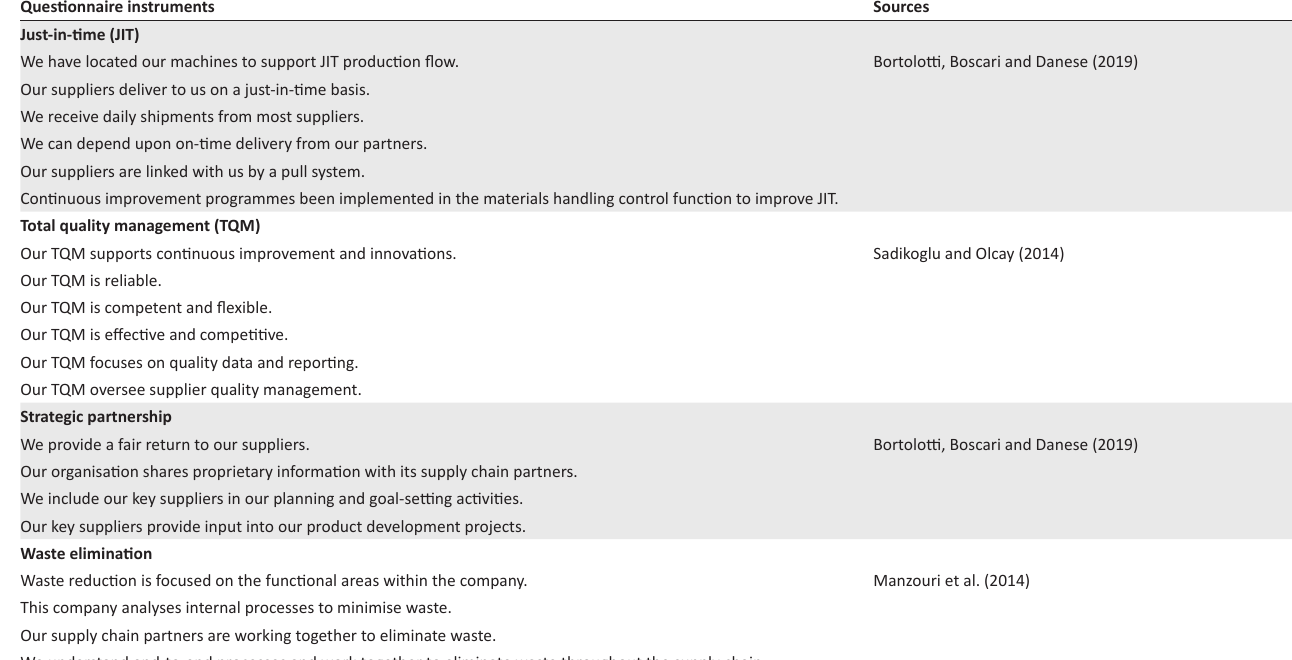
TABLE 1-A1: Measurement